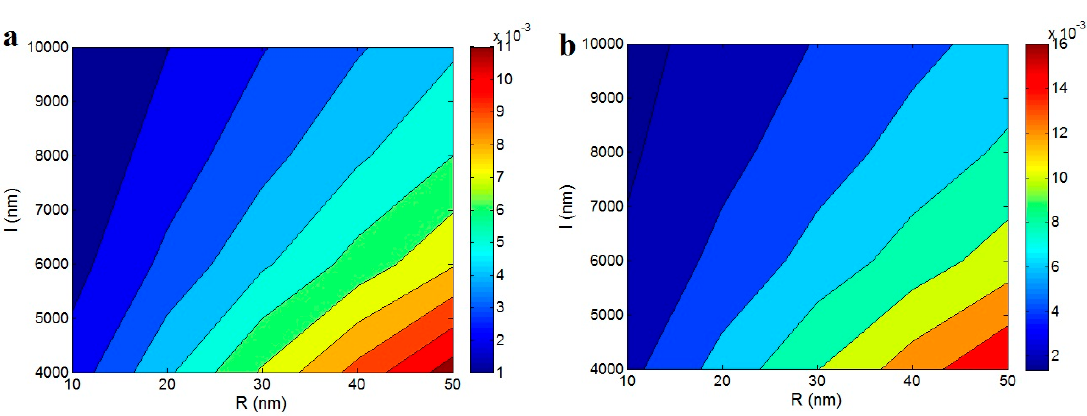
Figure 4. The contour plots for the influences of “ R ” and “ l ” parameters on the percolation threshold of nanoparticles based on ( a ) Equation (5) and ( b ) Equation (10).